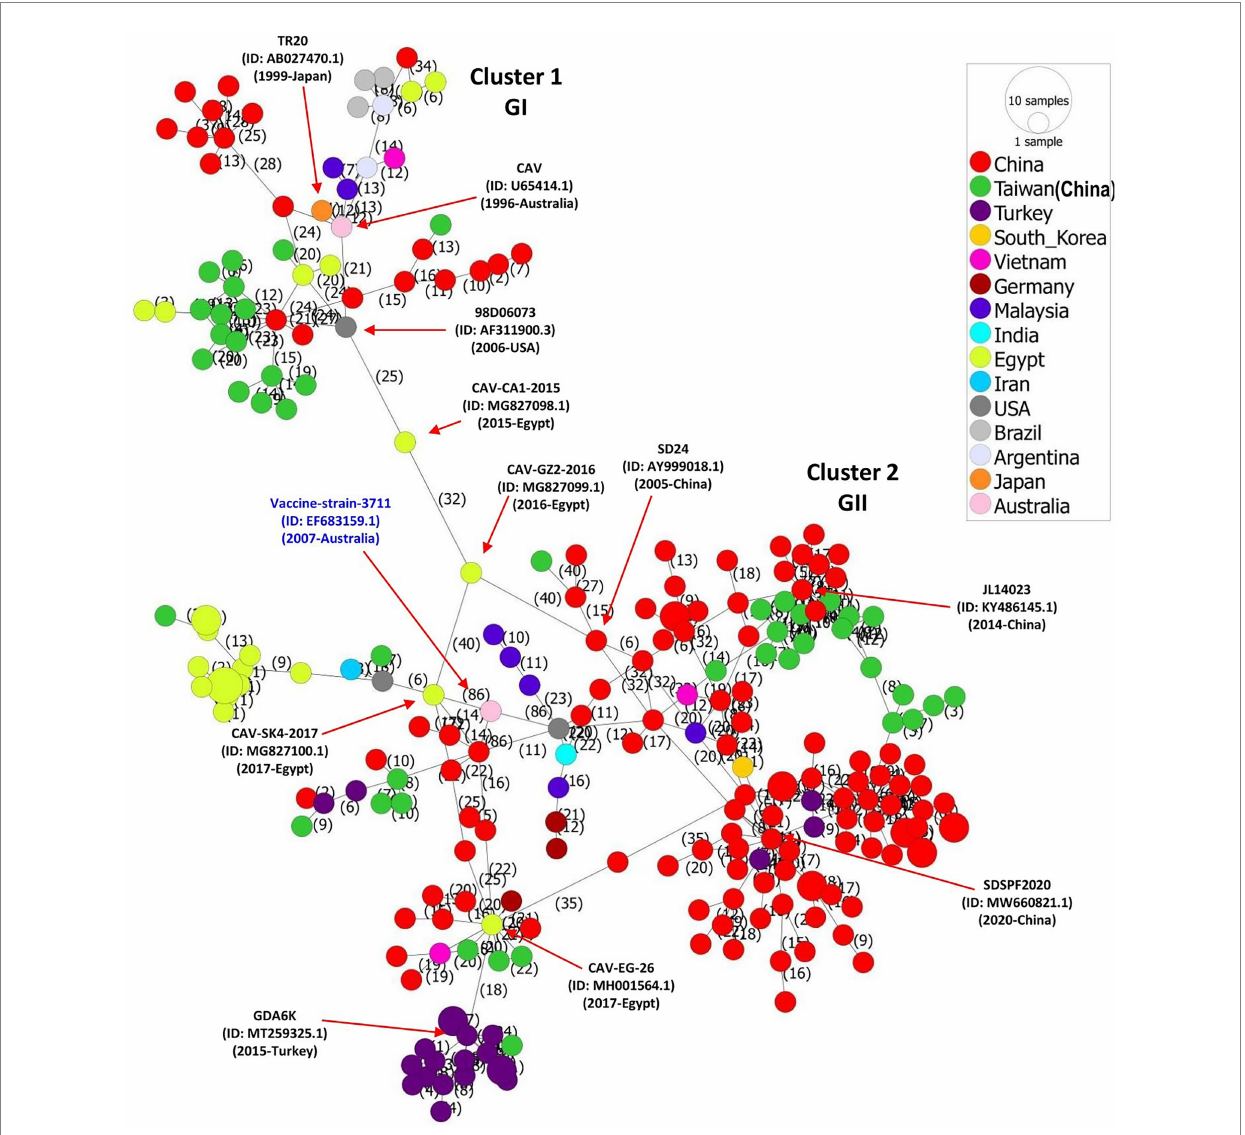
FIGURE 3 Phylogeographic network analysis of the full-length genome sequences of CAV, 1991–2020. The phylogenetic network of 243 full-length genomes of CAVs was inferred using the MSN network implemented by PopArt v1.7. Cluster 1 and Cluster 2 (relevant to GI and GII clades, respectively) are connected by three strains isolated in USA and Egypt, e.g., 98D06073 (GenBank ID: AF311900.3,2006-USA), CAV-CA1-2015 (GenBank ID: MG827098.1, 2015-Egypt), and CAV-GZ2-2016 (GenBank ID: MG827099.1,2016-Egypt) respectively, following 25 and 32 mutational substitutions within these strains. The number represents the mutational steps and substitutions. Each color represents a different country or